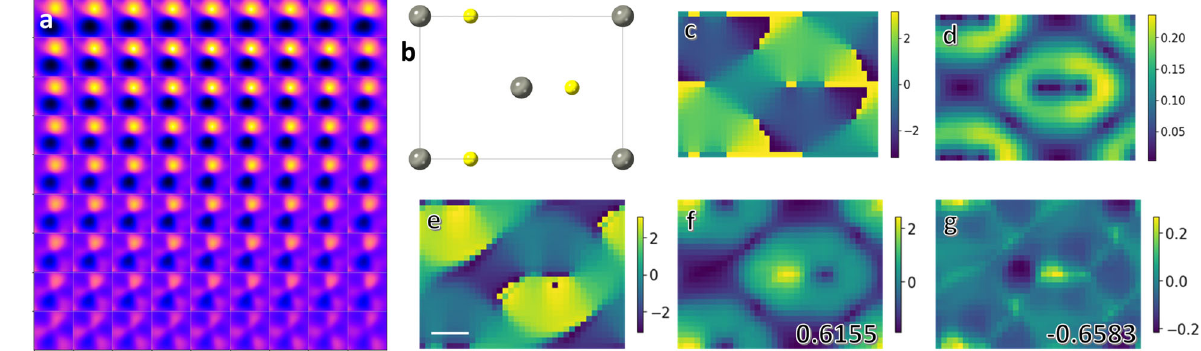
Fig. 4 Application to Simulated ZnS Data. a Latent space for 3D rrVAE of simulated ZnS [011] zone axis CBED patterns for a microscope operating a 60 kV with a 31 mrad probe forming aperture. A thickness of 76 Å was used in the simulation. Spatial incoherence with a FWHM of 0.75 Å is included. b Model of unit cell used for multi-slice simulation. c , d Angle and magnitude of the COM shift calculated from the simulated CBED patterns, respectively. e Rotation map obtained from rrVAE analysis. f , g Two latent variable distributions with Pearson r factor inset. 250 iterations were used. The scale bar in ( e ) is 1